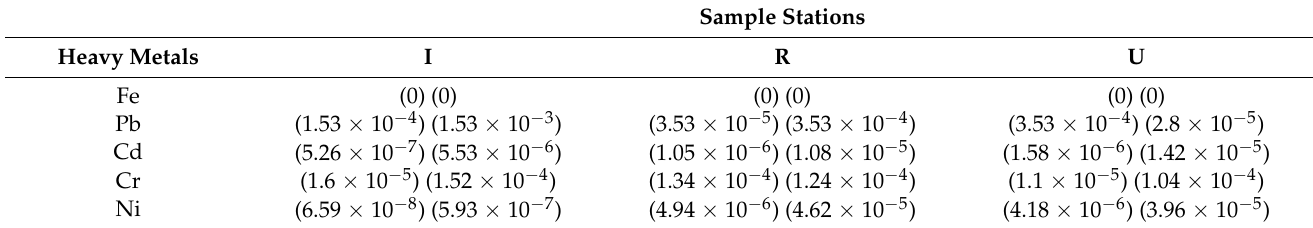
Table 9. Incremental Lifetime Cancer Risk ( ILCR ) for Vernonia amygdalina Delile in both adults and